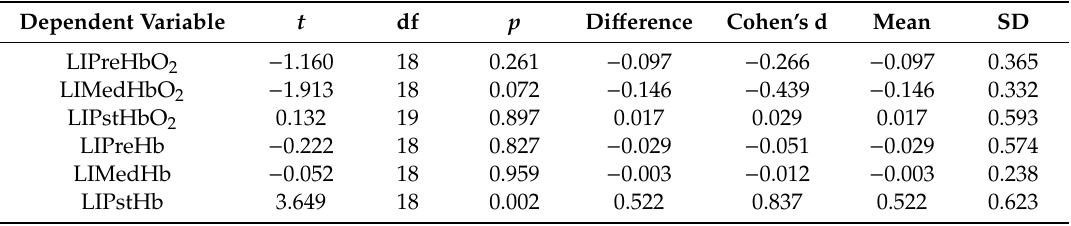
Figure 4. Mean fNIRS hemodynamic responses across the Conditions representing the polynomial contrasts quadratic trend analyses for each channel with ( a ) (Channel 1; n = 20), ( b ) (Channel 2 t; n = 20), ( c ) (Channel 3; n = 19), and ( d ) (Channel 4; n = 15). fNIRS biomarker measures were represented by HbO 2 -oxygenated hemoglobin (red line); Hb—deoxygenated hemoglobin (blue line); and HbT—total hemoglobin (green line). There were two significant quadratic trends denoted by symbol and color to the right of the trend line * ( p < 0.05), * ( p < 0.05) and there were two trends that approached significance, # ( p > 0.051–0.100). Table 4. Descriptive statistics and separate one-sample t -tests for fNIRS laterality measures for the Stroop test before meditation, after meditation, and Stroop test after meditation